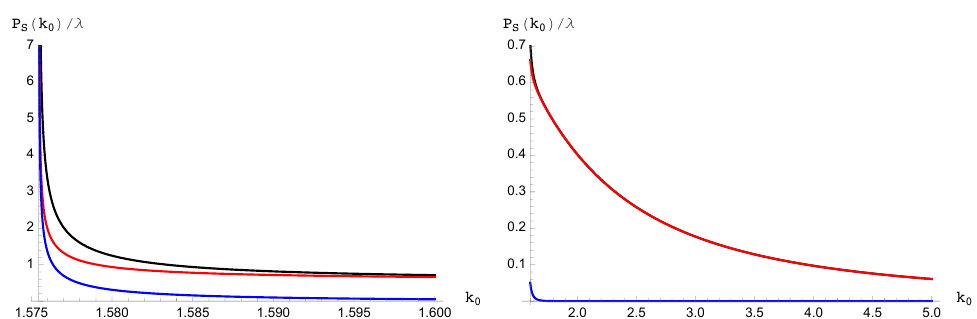
Figure 1 . The forward (red), backward (blue) and total (black) probabilities P S ( k 0 ) of Stokes scattering, with m = 1 .